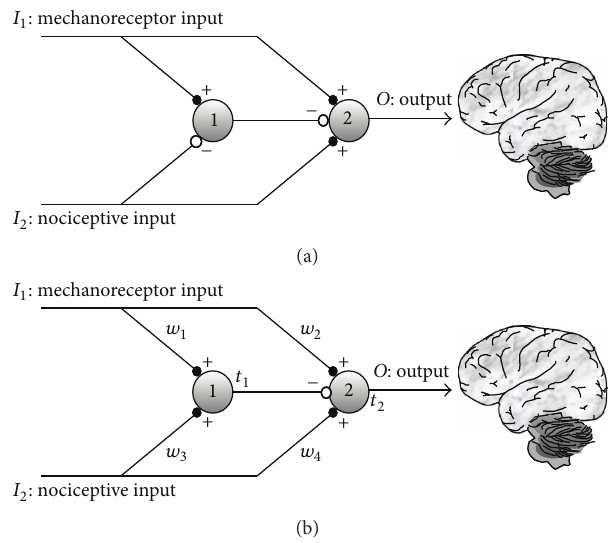
Figure 1: (a) The gate control mechanism proposed by Melzack and Wall in 1965. Both nociceptive and mechanoreceptors signals are projected to neurons in the substantia gelatinosa, represented by neuron 1, and towards the first central transmission neurons, represented by neuron 2. Mechanoreceptor signals are more intense (higher transmission rate) than nociceptive signals. Nociceptive signals inhibit neuron 1 (white dotted connection in figure) and, at the same time, produce excitation on neuron 2. (b) Current proposal: all nociceptive and mechanoreceptor axon terminals are excitatory. Synaptic weights ( 𝑤 𝑖 ) change according to NMDA plasticity. Firing thresholds, 𝑡 1 and 𝑡 2 , of neurons 1 and 2 also vary according to intrinsic